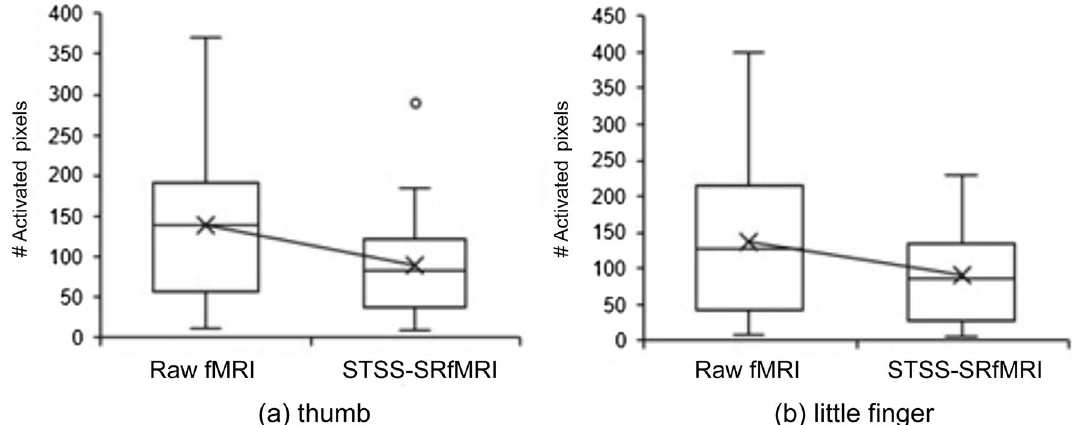
Figure 5. Comparison of the number of activated pixels extracted from the raw fMRI maps and the Static T2*WI-based Subject-Specific Super Resolution fMRI (STSS-SRfMRI) for the ( a ) thumb and ( b ) little finger. The STSS-SRfMRI maps yielded significantly fewer pixels than the raw fMRI maps for both the thumb (p < 0.001) and little finger (p < 0.001). The median (interquartile range (IQR)) for the raw fMRI and STSS-SRfMRI maps